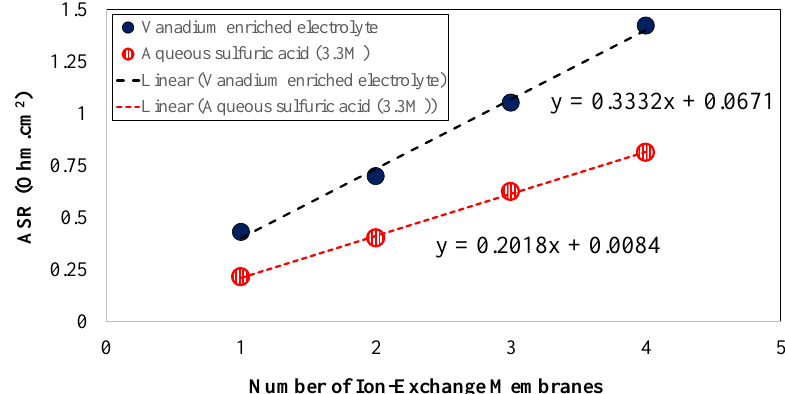
Figure 3. The area specific resistance (ASR) for all-vanadium redox flow batteries (VRFBs) assembled with multi-layer configurations of Nafion ® 115 (Note: The ASR values were corrected for the values without membrane).